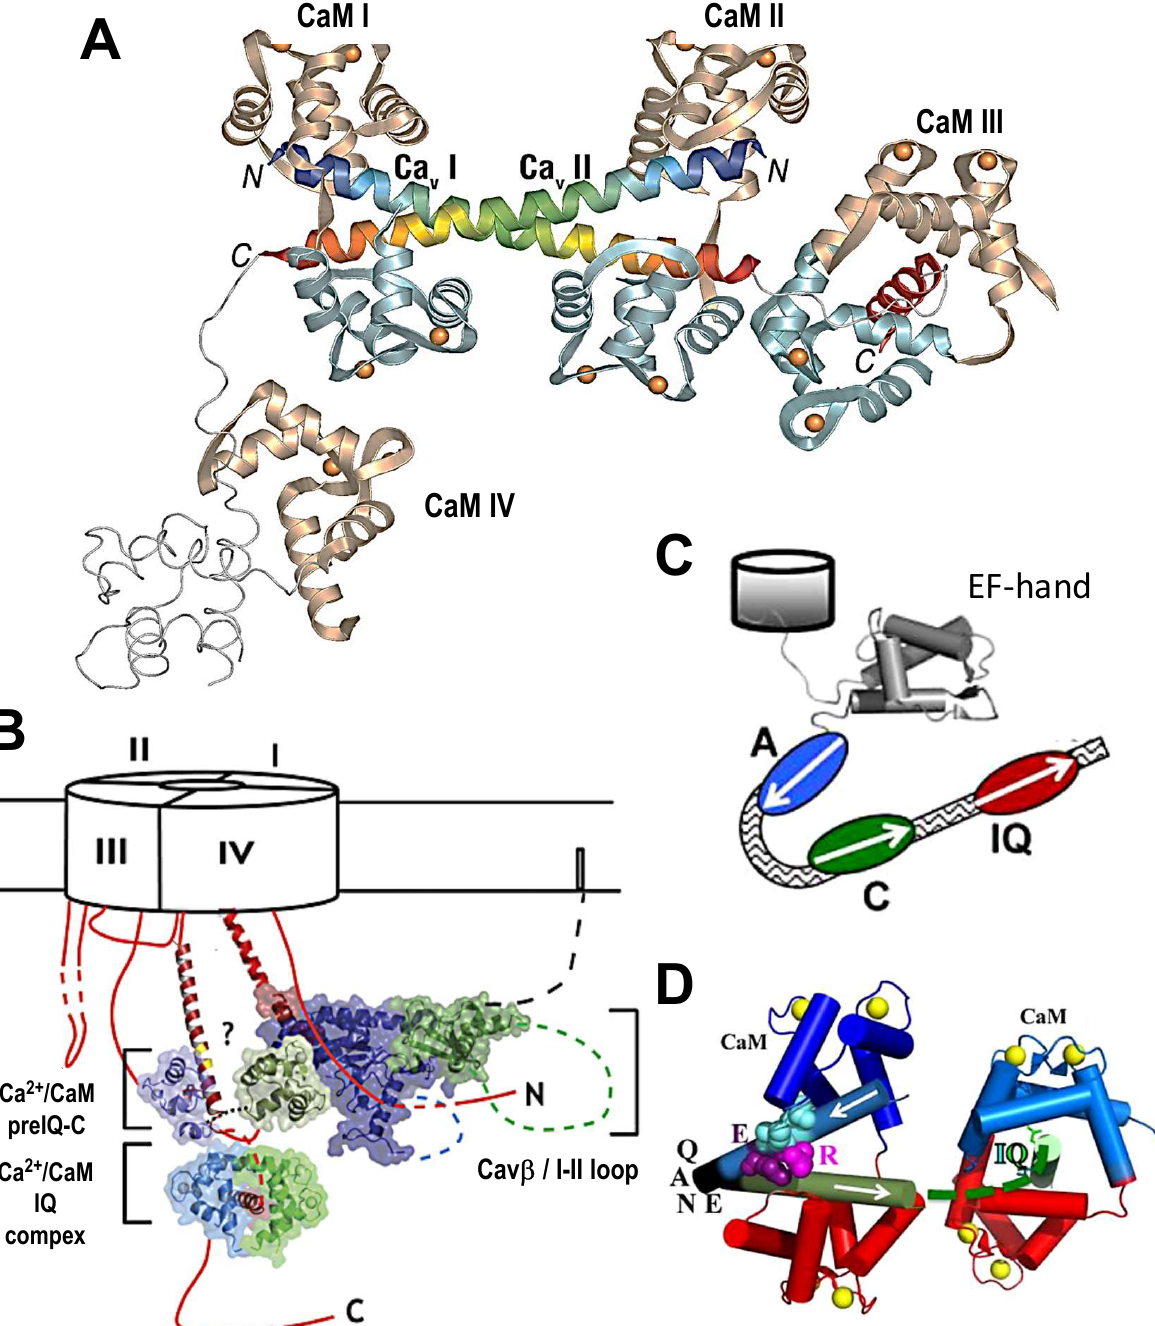
Figure 4. Structure models of preIQ-IQ/Cav1.2 bound with CaM. ( A ) Crystallographic structure of two preIQ-IQ bound with four CaM. CaM N-lobes, tan; C-lobes, light blue; Ca 2+ , gold Fig. 4 (IJMS; Kameyama et al.)